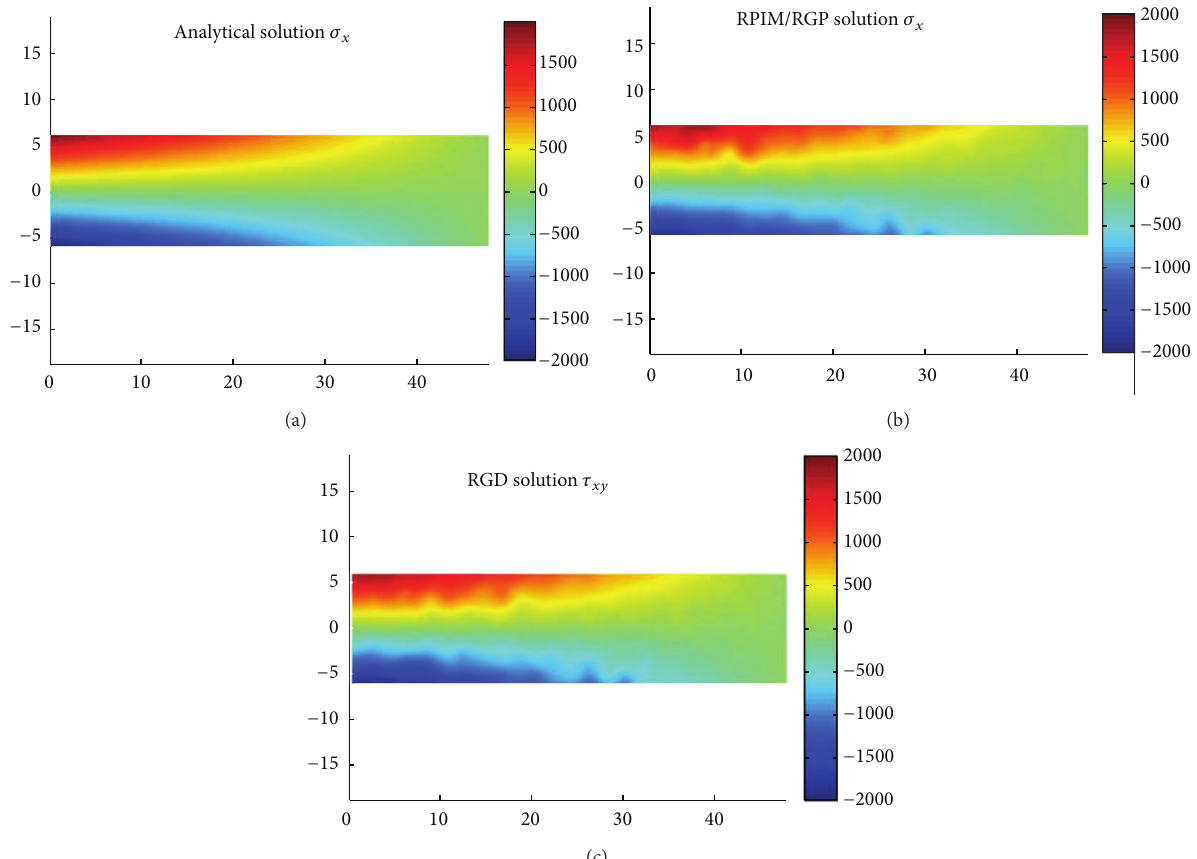
Figure 8: Stress 𝜎 𝑥 : analytical results (a), RGP numerical results (b), and RGD numerical results (c).